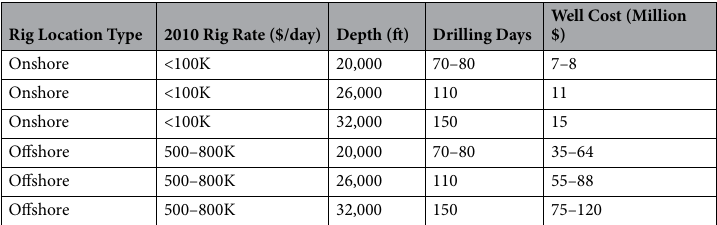
Table 1. Drilling costs in different settings based on data presented in 4